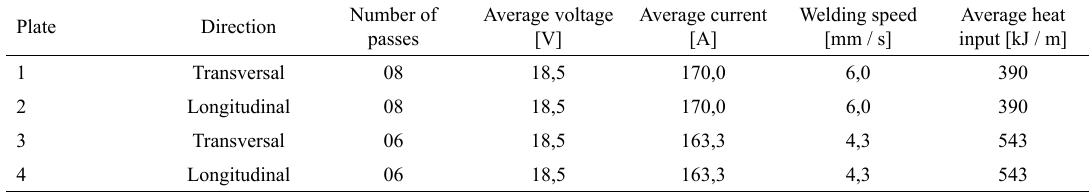
Figure 2. Apparatus mounted for welding Table 1. Welding parameters